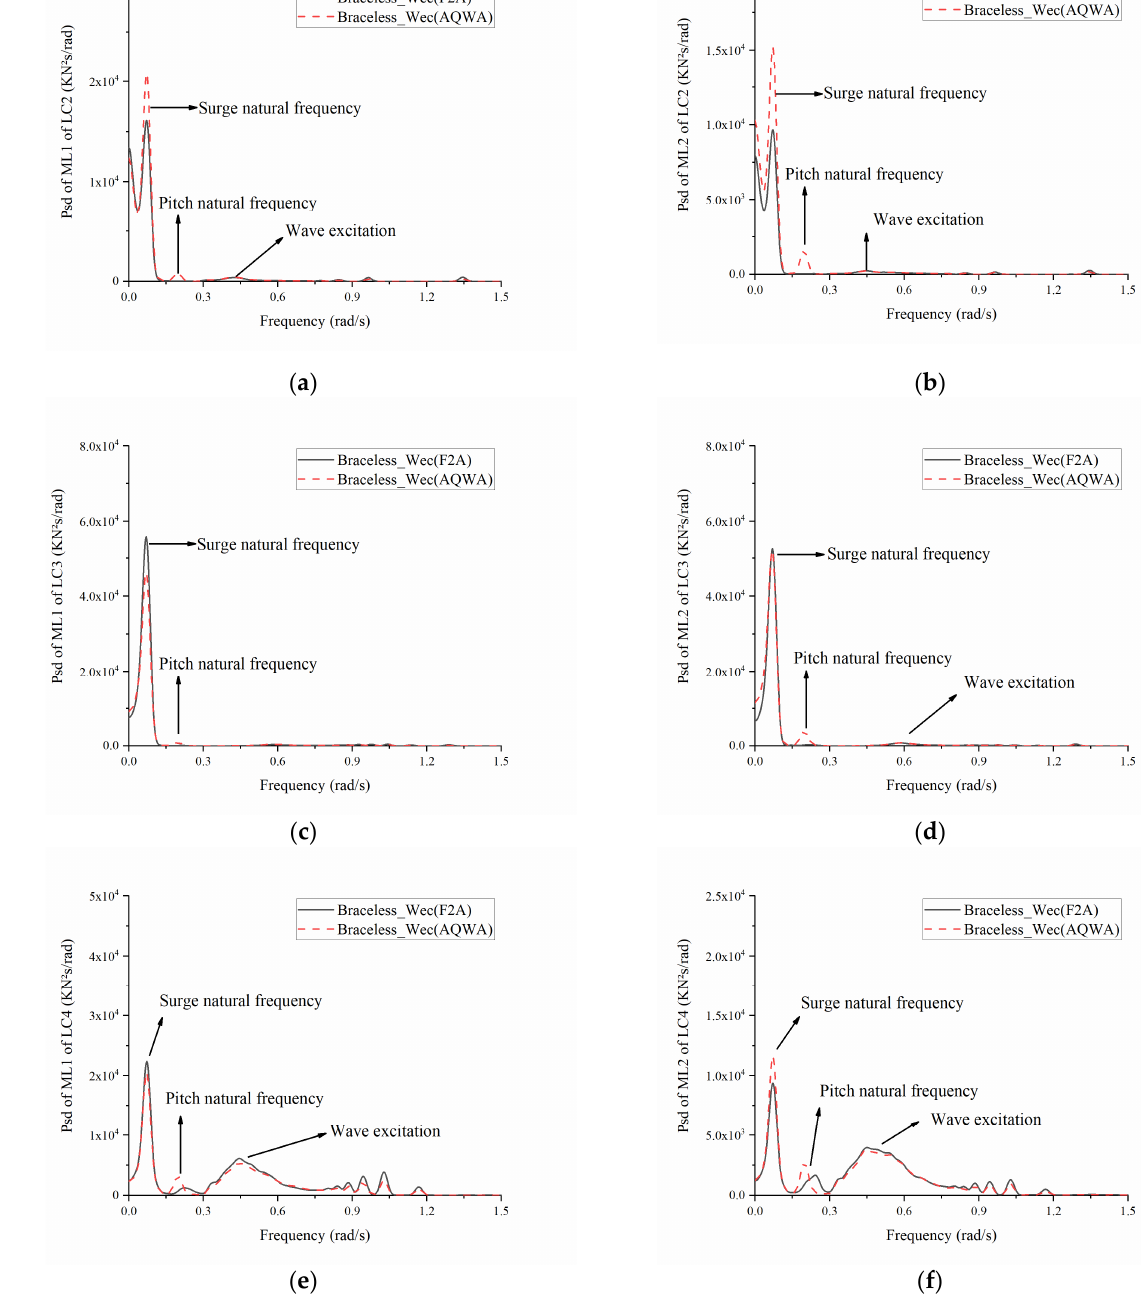
Figure 14. Comparisons of the PSD of the mooring line force of: ( a ) ML1 of LC2; ( b ) ML2 of LC2; ( c ) ML1 of LC3; ( d ) ML2 of LC3; ( e ) ML1 of LC4; ( f ) ML2 of LC4.